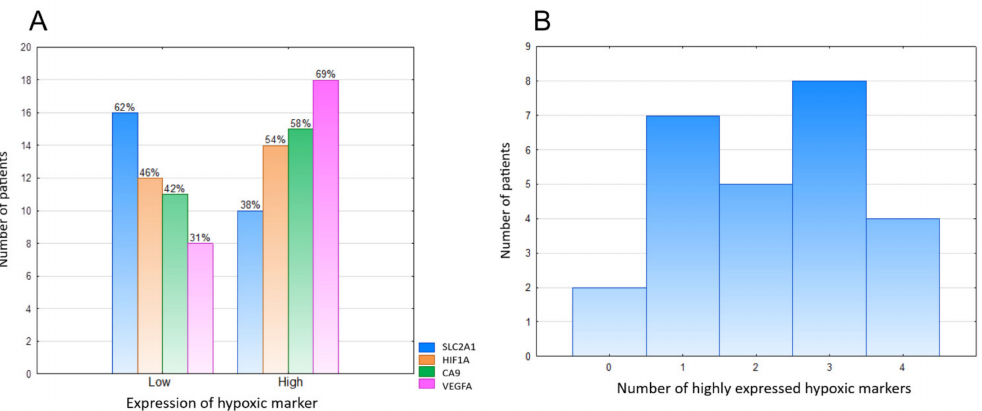
Figure 1. Immunohistochemical expression profile of hypoxic markers (SLC2A1, HIF1A, CA9, VEGFA) in the current cohort of MPNST. VEGFA was the most commonly highly expressed hypoxic marker, whereas SLC2A1 expression was low in most tumors ( A ). The vast majority of MPNSTs highly expressed at least one marker of hypoxia ( B ). Abbreviations: MPNST—malignant peripheral nerve sheath tumor, SLC2A1—solute carrier family 2 member 1, HIF1A—hypoxia-inducible factor-1 α , CA9—carbonic anhydrase 9, VEGFA—vascular endothelial growth factor